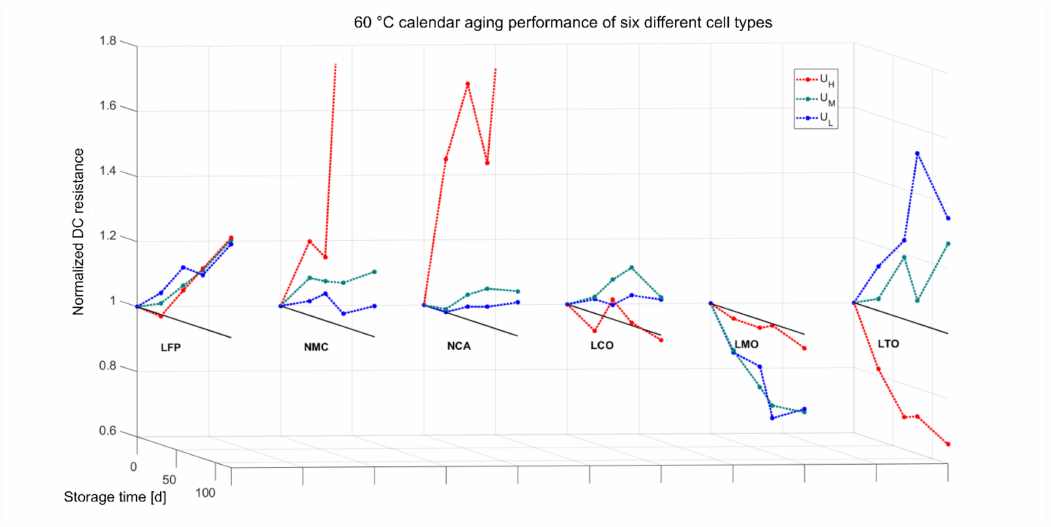
Figure 8. Normalized DC resistance increase of six chemistries at 60 ◦ C storage over 120 days at three storage voltages (U L -voltage low, U M -voltage mid, U H -voltage high), every plot point resembles the average of all measurements at that same condition, current pulse for measurement for all cells at U M, with NMC and NCA cells dead near the end of the aging